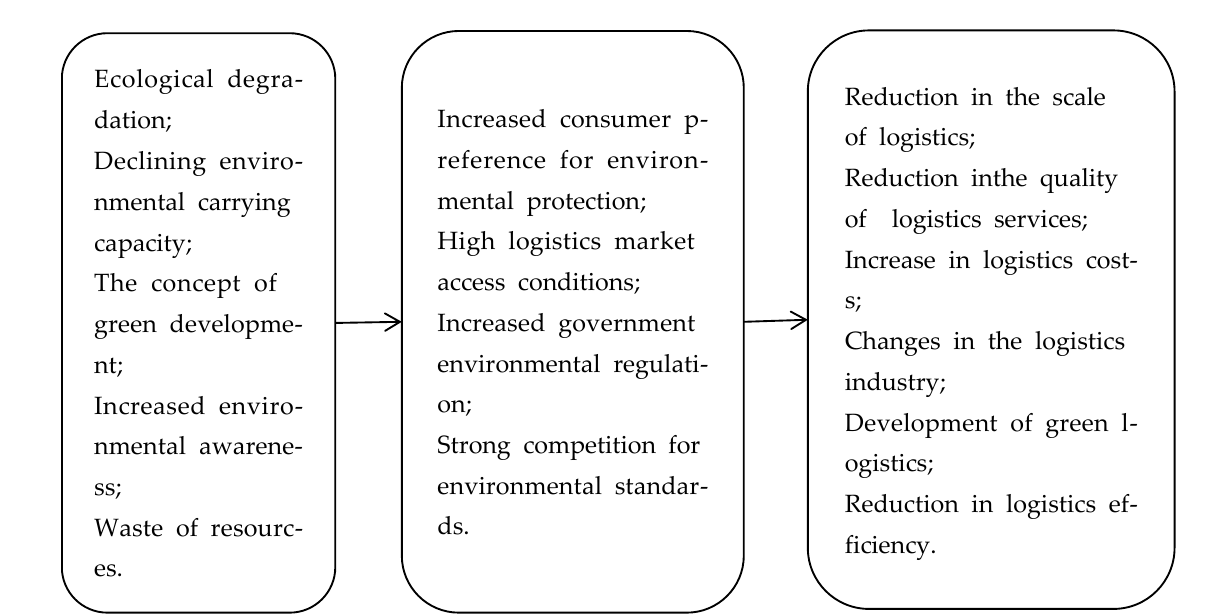
Figure 2. Mechanism underlying the role of the ecological environment in logistics activities.